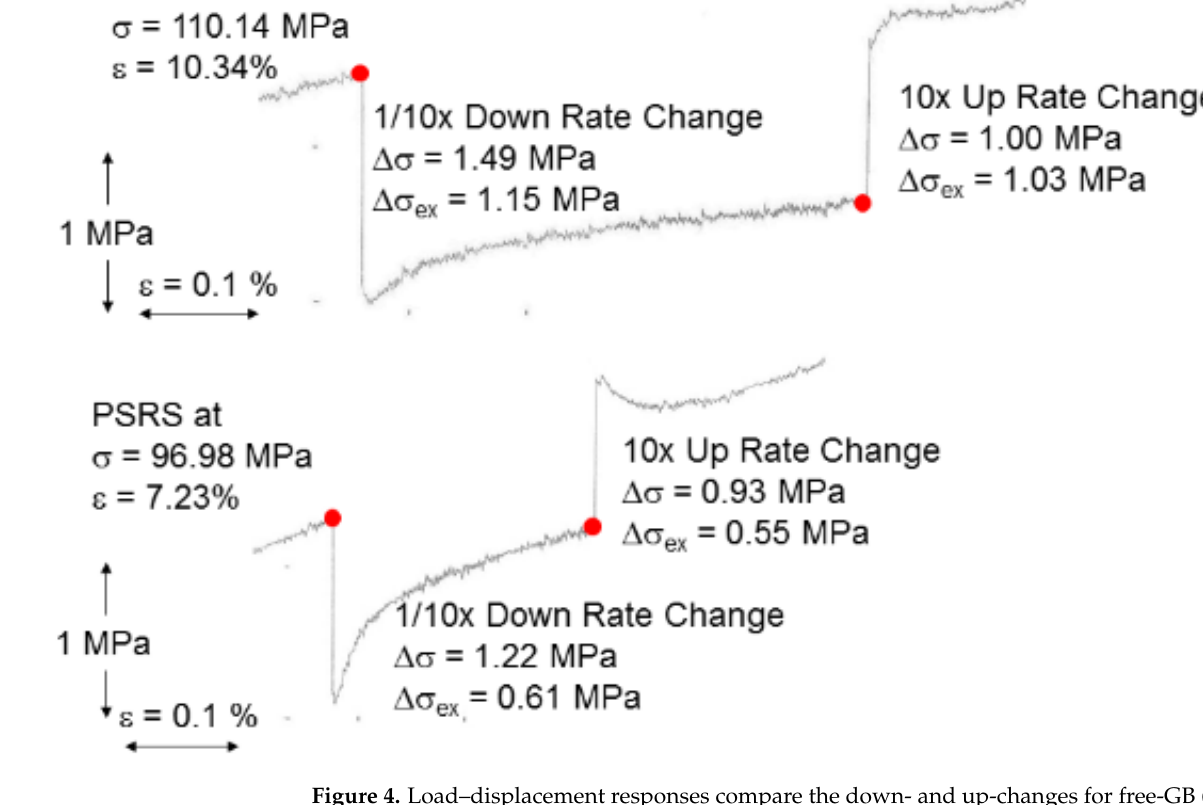
Figure 4. Load–displacement responses compare the down- and up-changes for free-GB ( top ) and sealed-GB ( bottom ) of AA1100 tested at 195 K. The red dots indicate the stress from which the down- and up-rate change is made. The sealed-GB response with greater super-saturation give rise to larger pinning effect. The initial almost flat region on the up-change gives the thermodynamic response expected followed by depinning (yield point) due to insufficient density of mobile dislocation sources to maintain the increased strain rate [34].